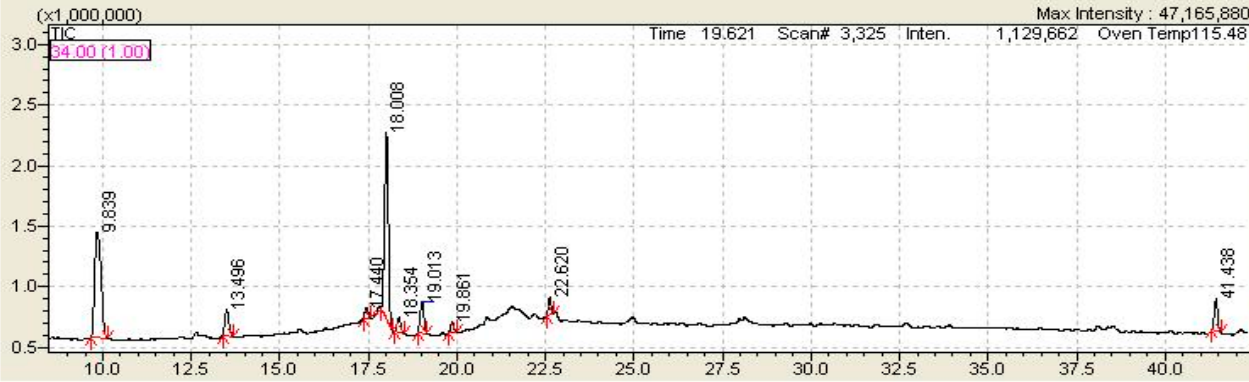
Figure 7. Chromatogram of N. Sativa oil characterized by GC-MS analysis.